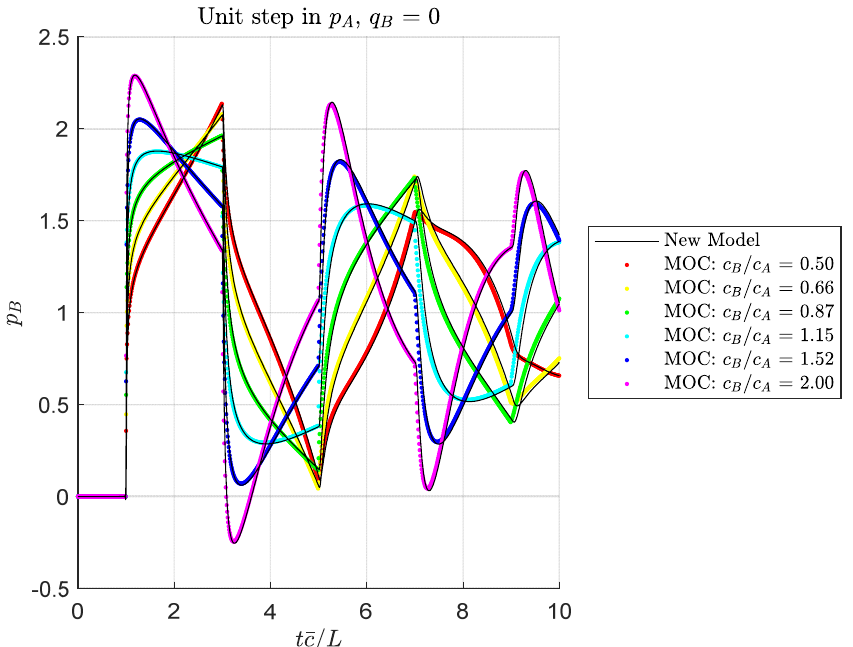
Figure 3. Outlet pressure response to a unit step in inlet pressure, for a closed exit, showing effect of taper ratio.